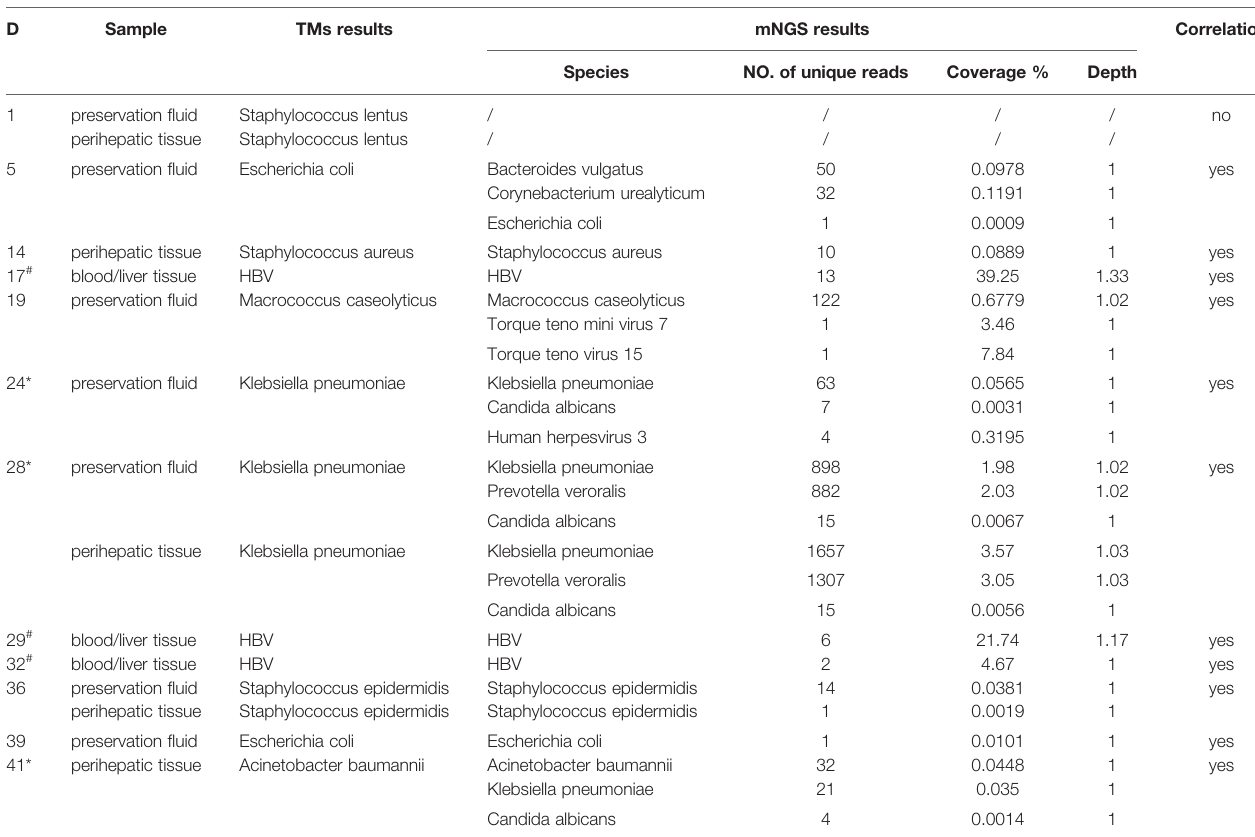
TABLE 2 | mNGS results of 12 TMs-positive sample of donors.